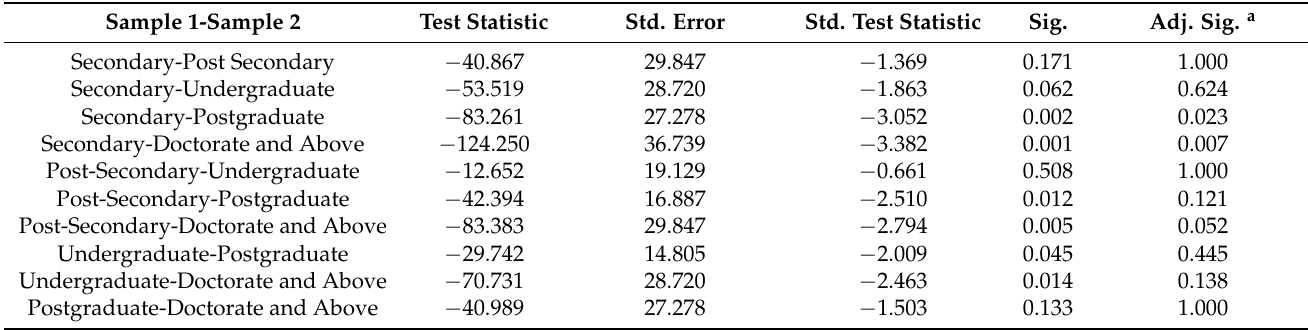
Table 11. Post hoc analysis—art fraud and forgery.